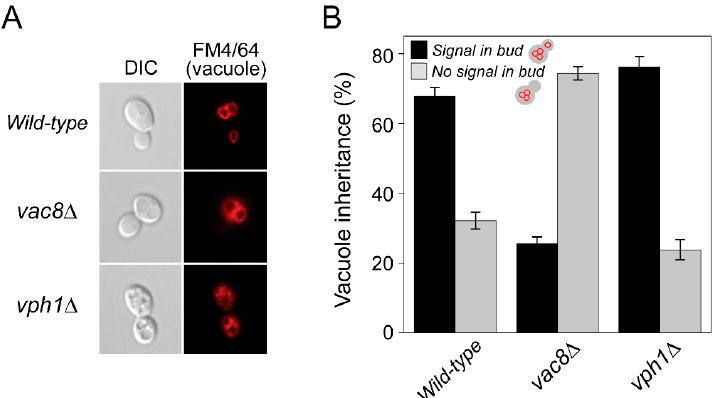
Figure 5. Damaged yeast vacuoles are normally inherited by daughter cells during cell division. Wild-type or mutant yeast cells were grown in the presence of FM4/64, a lipophilic dye for vacuoles, and analyzed for vacuole inheritance during cell division. Yeast cells lacking Vac8p, a vacuolar protein essential for vacuole inheritance, were used as control. Representative images from each cell type ( A ) and quantitation for vacuole inheritance ( B ) are shown. Magnification: 100×. DIC, differential interference